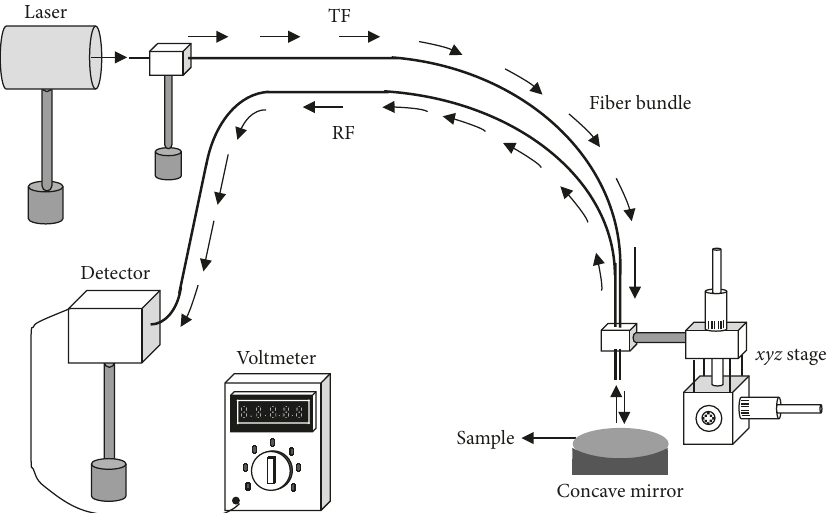
Figure 2: Experimental setup of rhodamine B concentration detection using fiber bundle and concave mirror as a reflector and sample